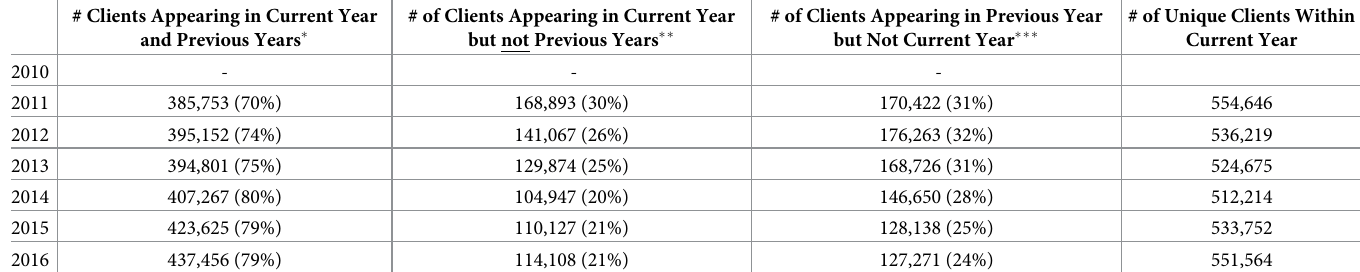
Table 1. RSR linkage results by year.